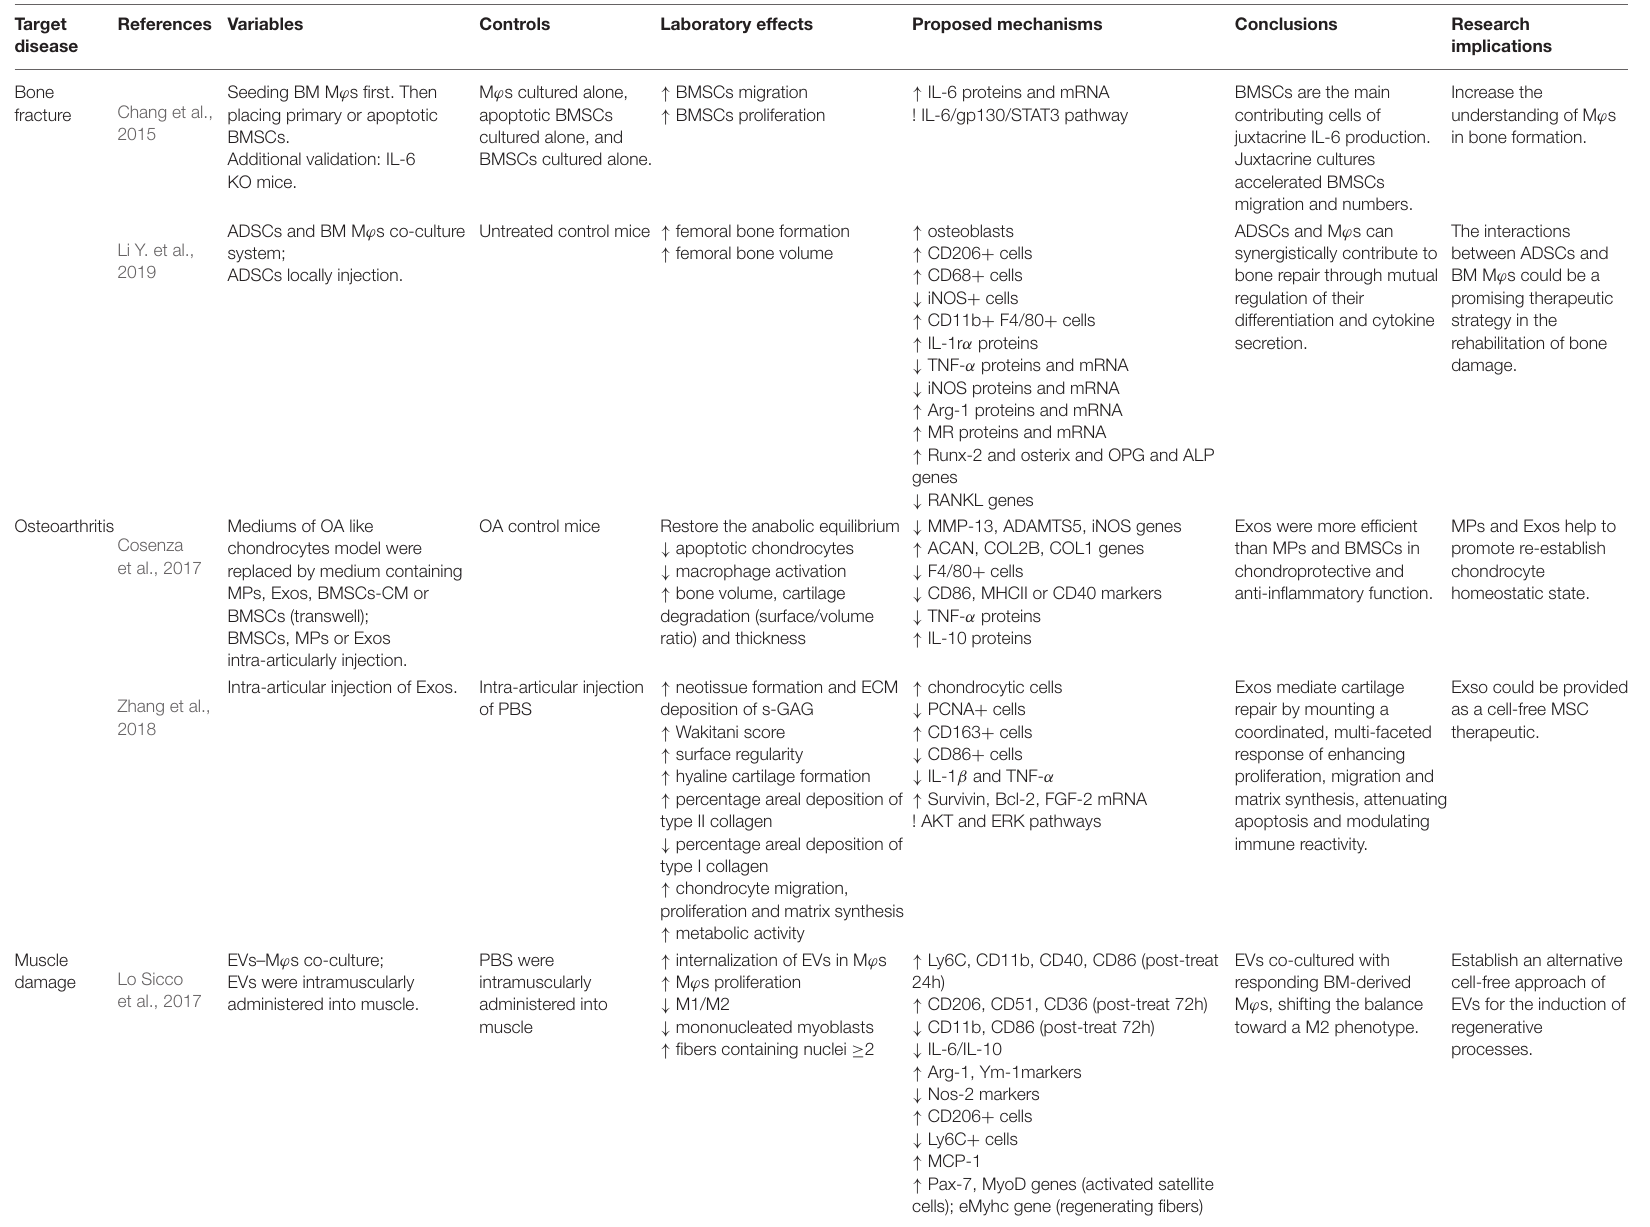
TABLE 3 | Evaluations and results list of selected studies in which the therapeutic potential of the administration of MSCs for the treatment of musculoskeletal